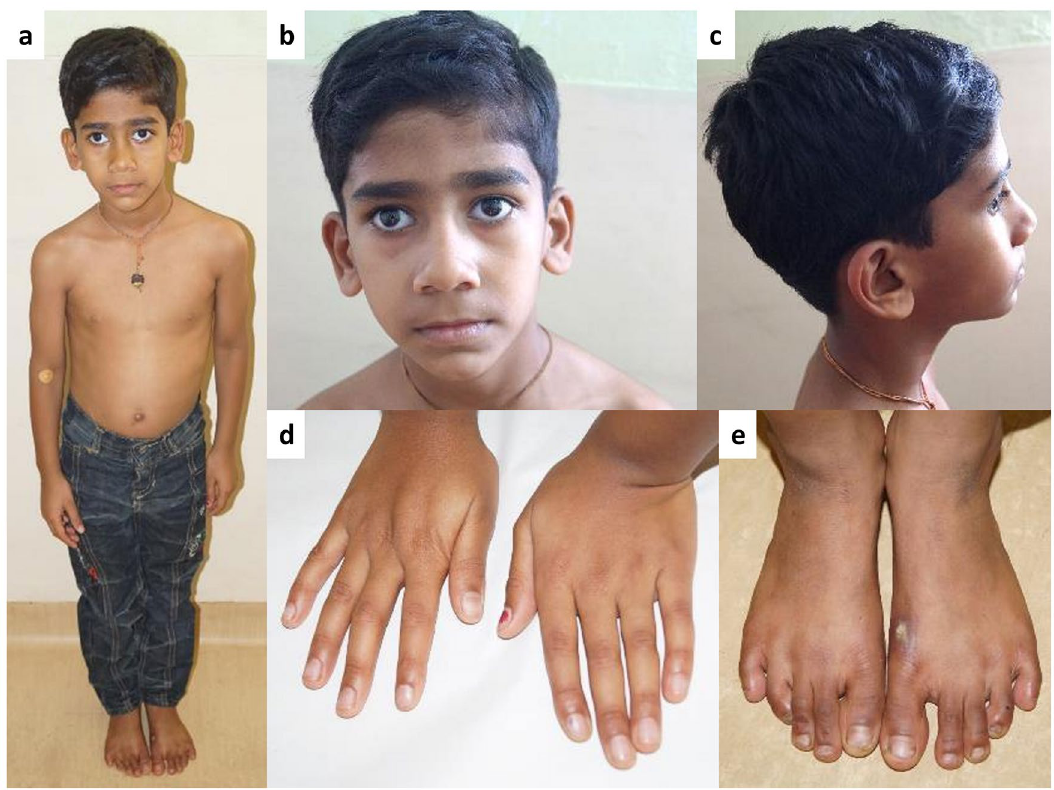
Figure 2. Photographs of patient 10 with the homozygous variant c.2861G > A, p.(Arg954His) in FBN1 . He had normal stature (0.01 z) at 5 years 8 months of age with long face, exotropia of right eye, thin vermilion of upper lip ( a – c ), normal fingers ( d ) and pes planus ( e